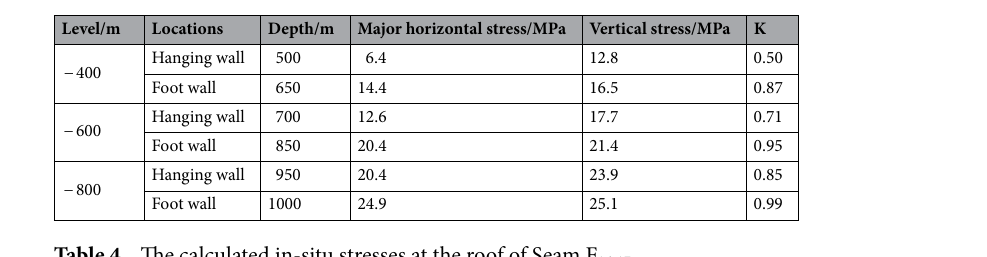
Table 4. The calculated in-situ stresses at the roof of Seam F 16-17